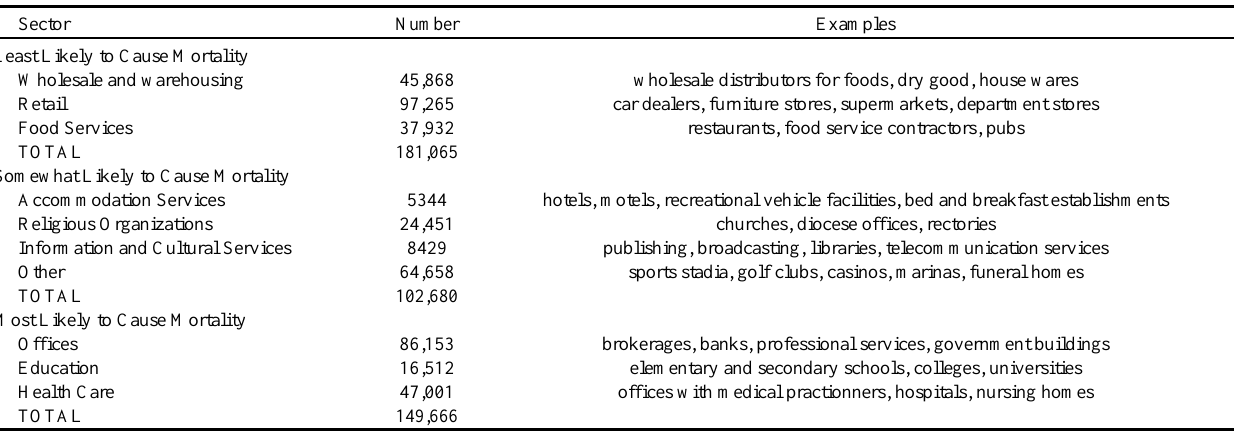
Table 4 . Number and description of buildings in each broad class used in our simulation. Data from Natural Resources Canada (NRCAN; 2007). Numbers are not exactly as in NRCAN (2007) because we reduced some sectors to account for buildings over 12 storeys tall included in the original data.